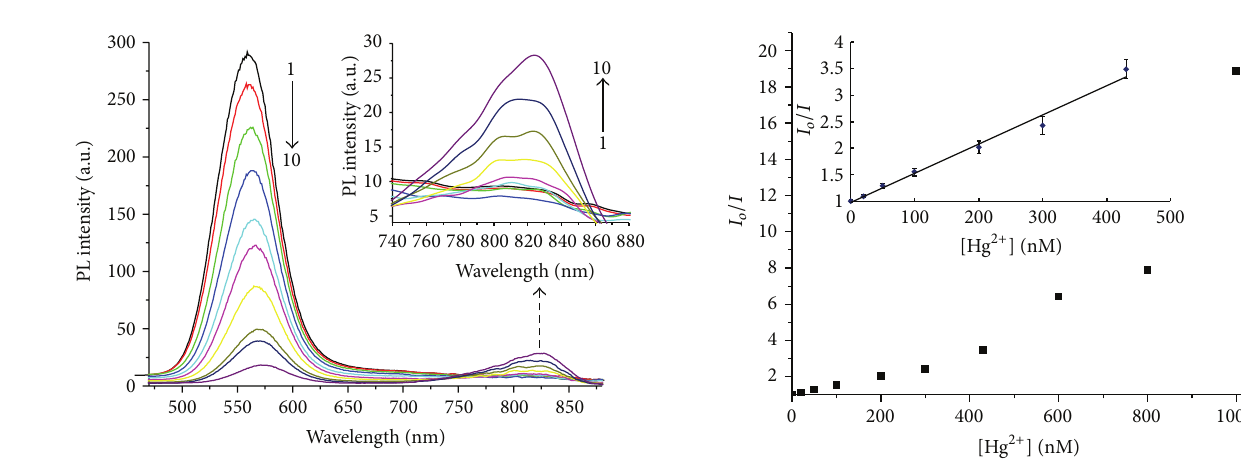
Figure1:EffectofHg(II)ionsonthePLspectraofCdTeQDs( 𝜆 565 nm) with the concentration of Hg 2+ at 0.0, 0.2, 0.5, 1.0, 2.0, 3.0, 4.3, 6.0, 8.0, and 10.0 × 10 −7 M (from 1 to 10). The inset depicts the emergence of an NIR emission band on the addition of Hg(II) ions.